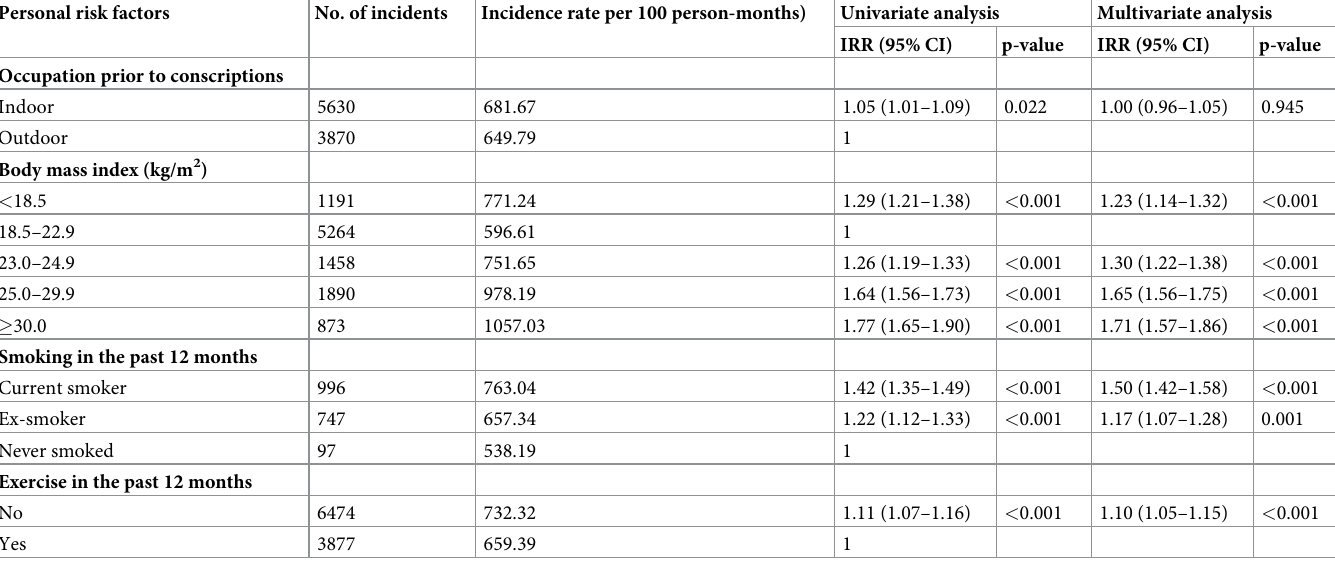
Table 6. Personal risk factors associated with the production of dark brown urine by new conscripts during basic military training. Personal risk